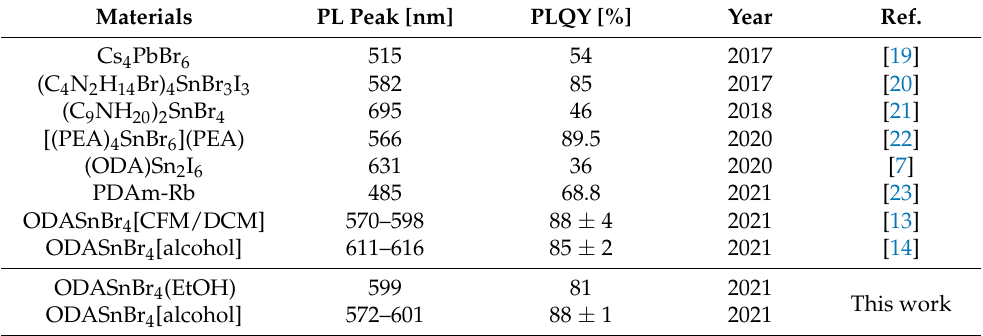
Table 1. Comparison of PL characteristics of various low-dimensional metal halide perovskites. Materials PL Peak [nm] PLQY [%] Year